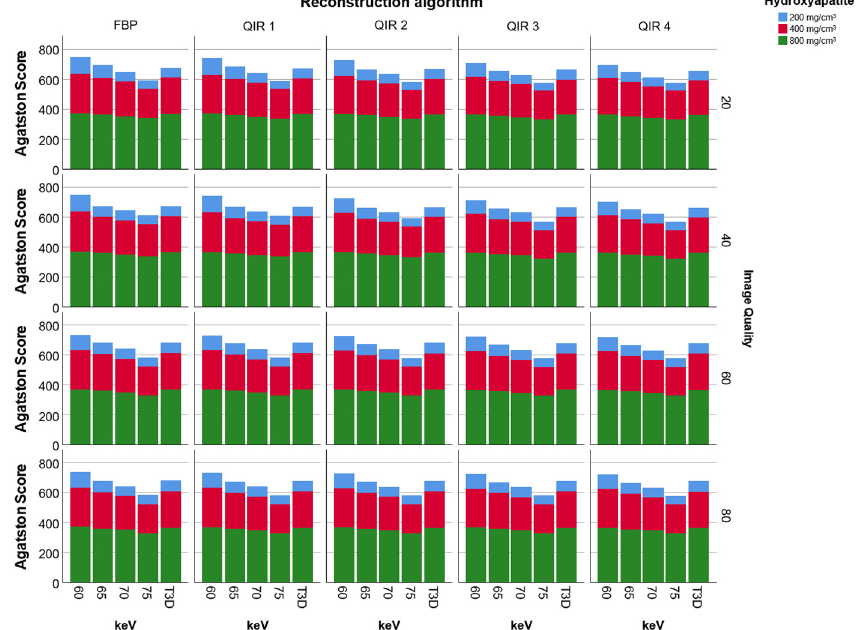
Figure 2. Data from scans of an anthropomorphic chest phantom with an insert for calcium scoring shows that virtual monoenergetic image reconstructions with increasing keV ( p < 0.001 for each 5 keV increase) and increasing strength levels of Quantum Iterative Reconstruction (QIR; p < 0.001 for each increase in strength level) lead to decreasing calcium scores. There was no difference between calcium scores of 65 keV monoenergetic and T3D (equivalent to polychromatic 120 kV) reconstructions ( p > 0.05). There was no difference of calcium scores between various degrees of image quality and hence, radiation dose (all, p > 0.05).